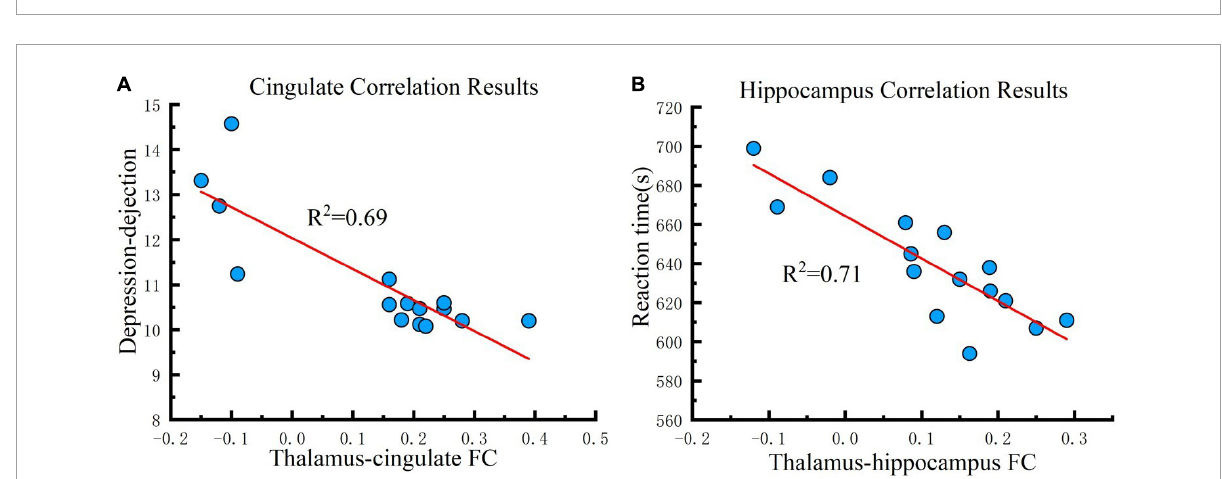
FIGURE6 Correlation results. (A) Cingulate correlation results. FC changes between the thalamus and cingulate are correlated with depression-dejection in the fifth test across all participants under the real tDCS condition. (B) Hippocampus correlation results. FC changes between the thalamus and hippocampus are correlated with the reaction time of PVT in the fifth test across all participants under the real tDCS condition. The coefficient of determination denoted R 2 in the figure indicates the proportion of depression-dejection that could be predicted from FC variation. FC, functional